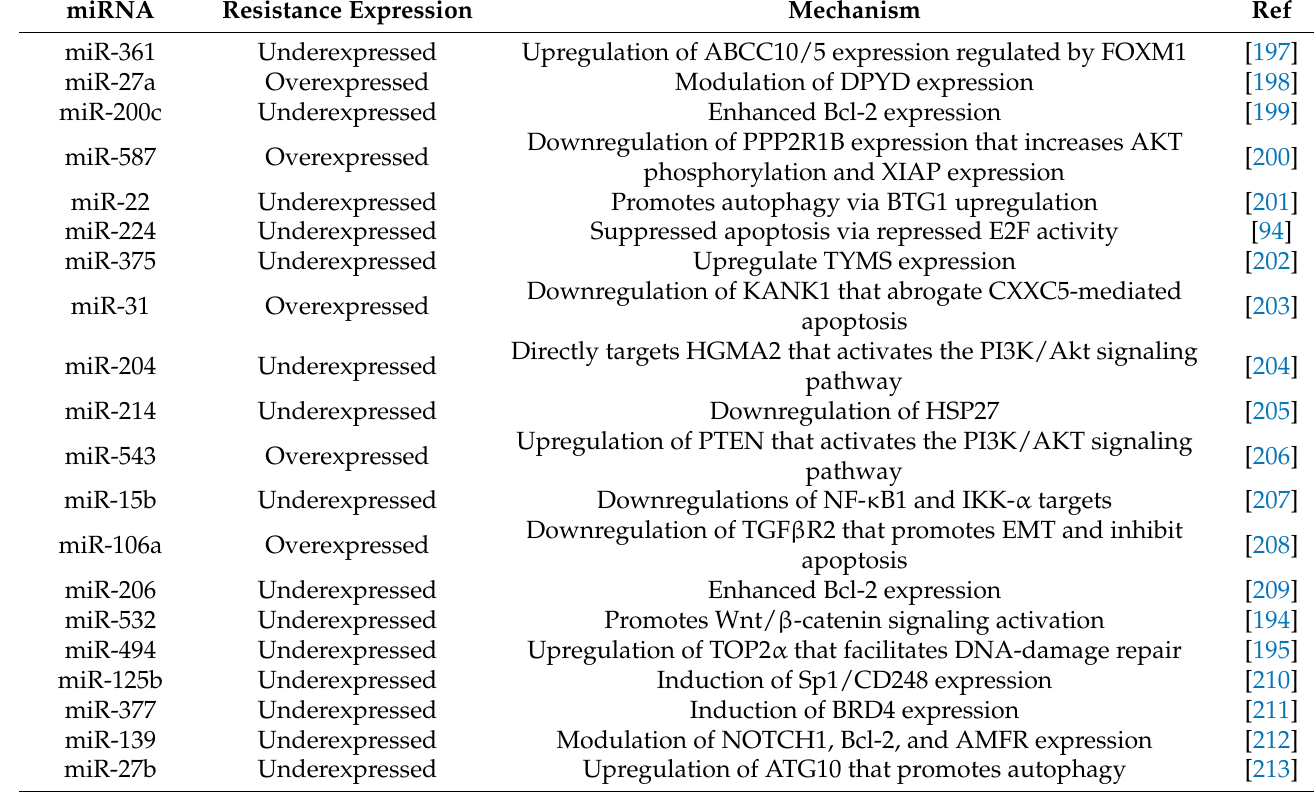
Table 1. MiRNAs that mediate 5-FU resistance in colon cancer cells through the modulation of various pathways.